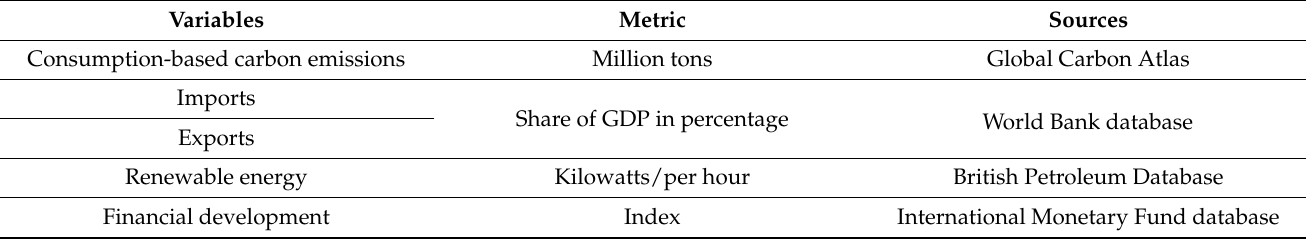
Table 1. Description of